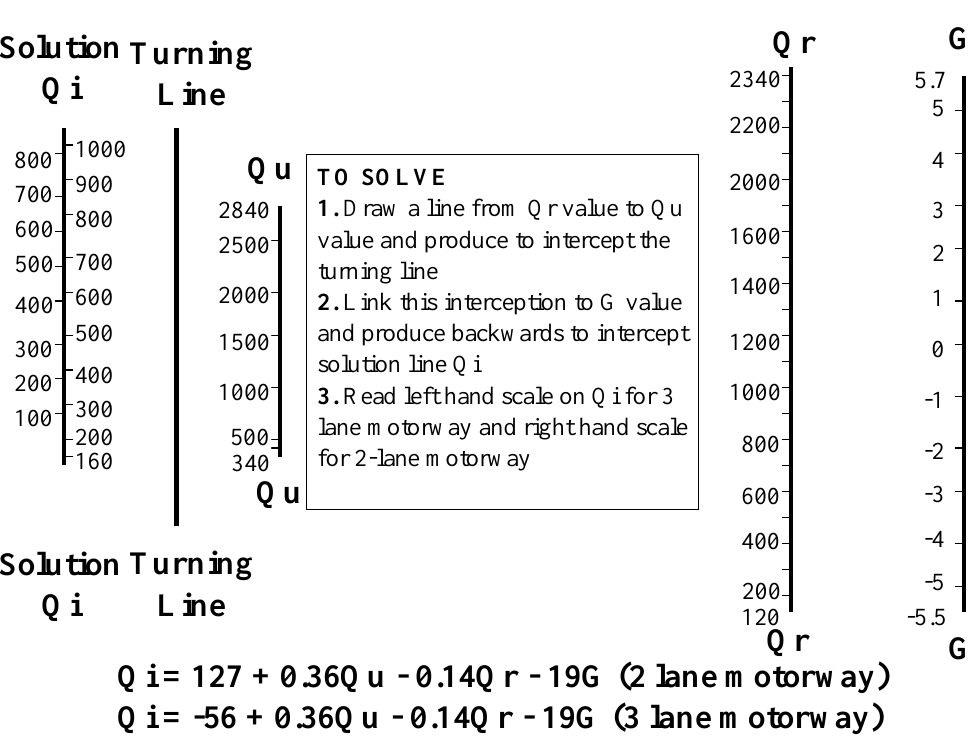
Figure 4. A nomograph to help to calculate the inside lane flow Qi (from Berresford and Seddon